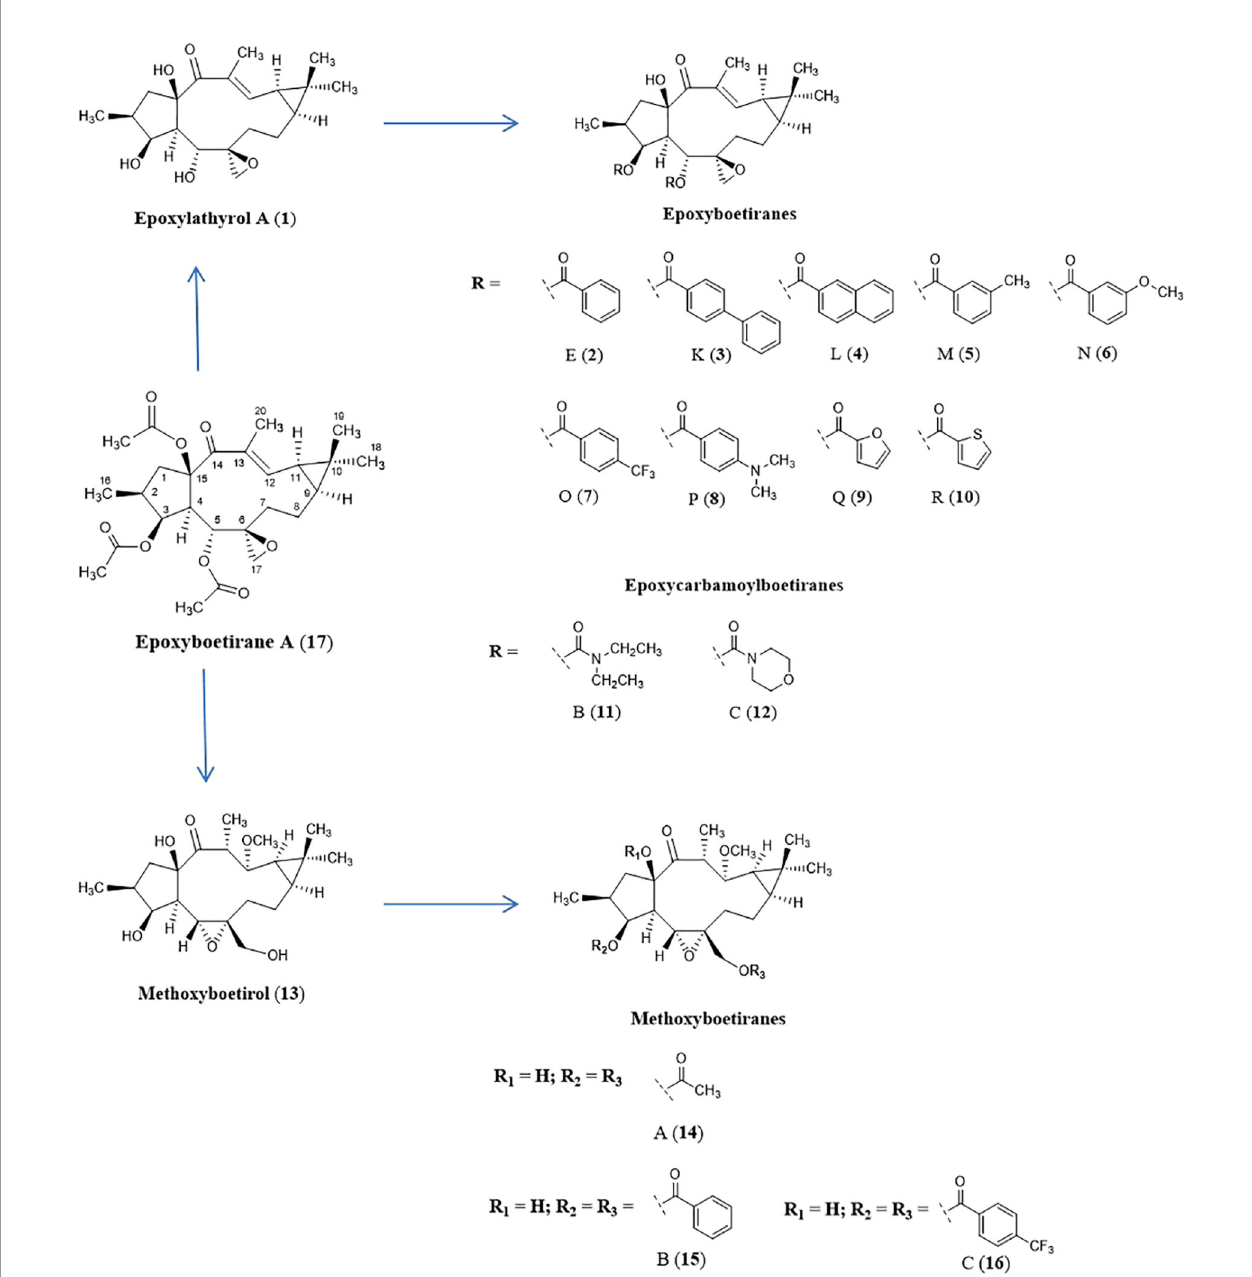
FIGURE 1 | Structures of compounds 1 – 17